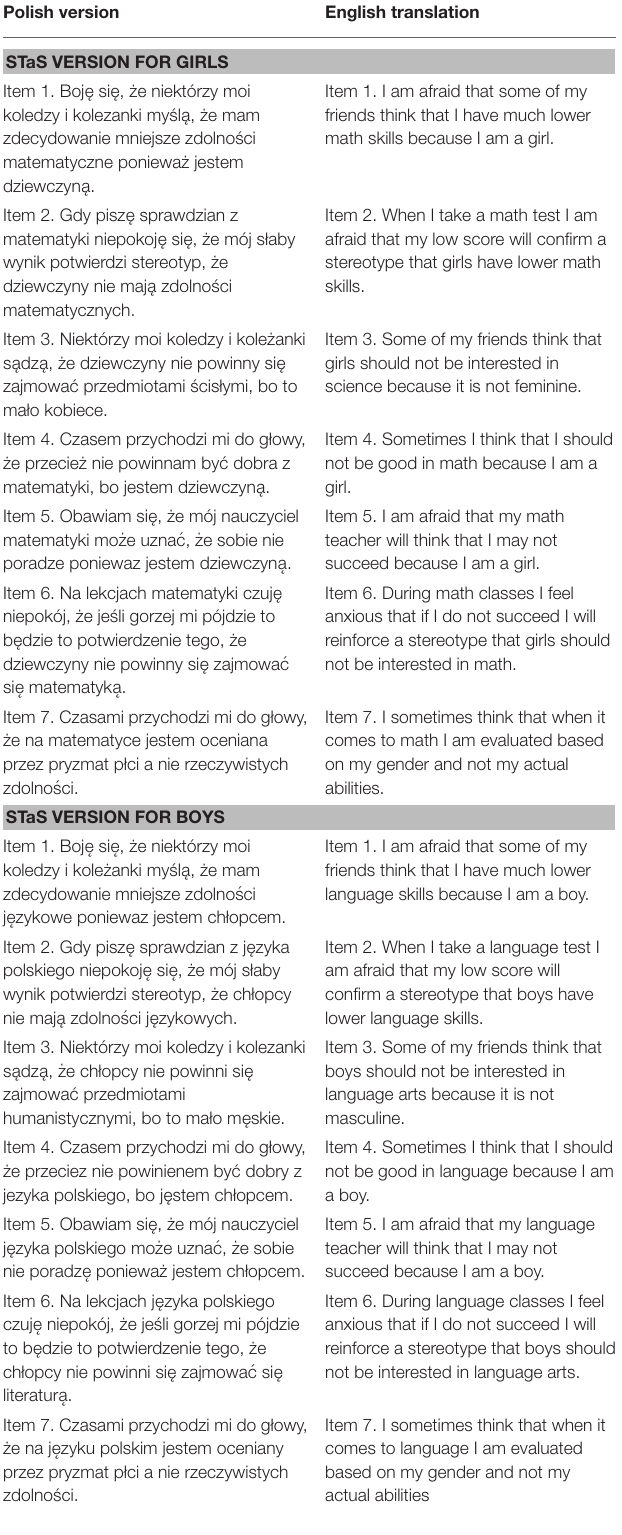
TABLE 1 | Items of two versions of the Stereotype Threat at School (STaS) Scale: girls in mathematics and boys in language arts in the original version and English